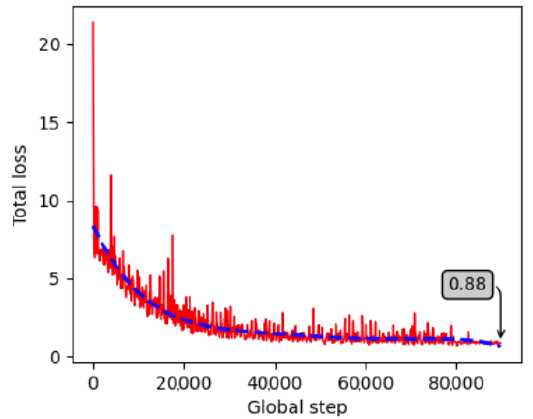
Figure 12. Progress of the training loss for the created laboratory